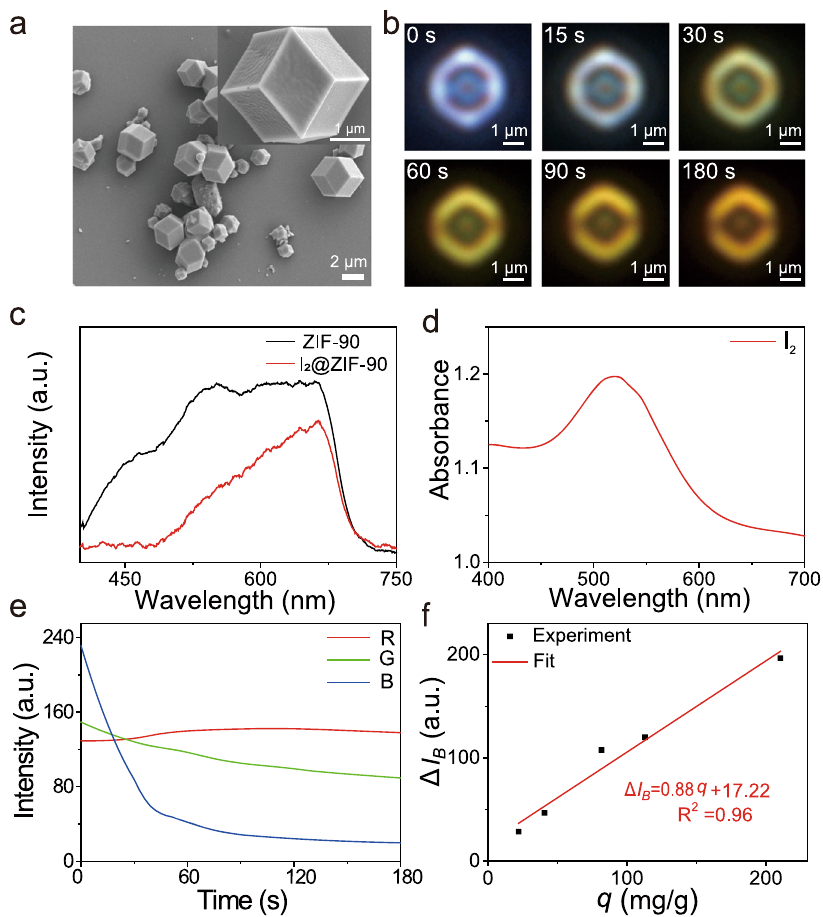
Fig. 2 Structure characterization of ZIF-90 particles and in situ DFM data of gaseous I 2 adsorption on single ZIF-90 particles. a SEM image of ZIF-90 particles. b Time-lapsed DFM images of gaseous I 2 adsorption on single ZIF-90 particles (The concentration of gaseous I 2 is 1 mM). c Scattering spectra of ZIF-90 particles before and after capturing I 2 . d The UV – vis adsorption spectrum of gaseous I 2 . e RGB values of DMF vs reaction time for capture of gaseous I 2 by single ZIF-90 particle. f Plot of the change of B value ( △ I B ) from the DFM image as a function of adsorption amount of I 2 ( q